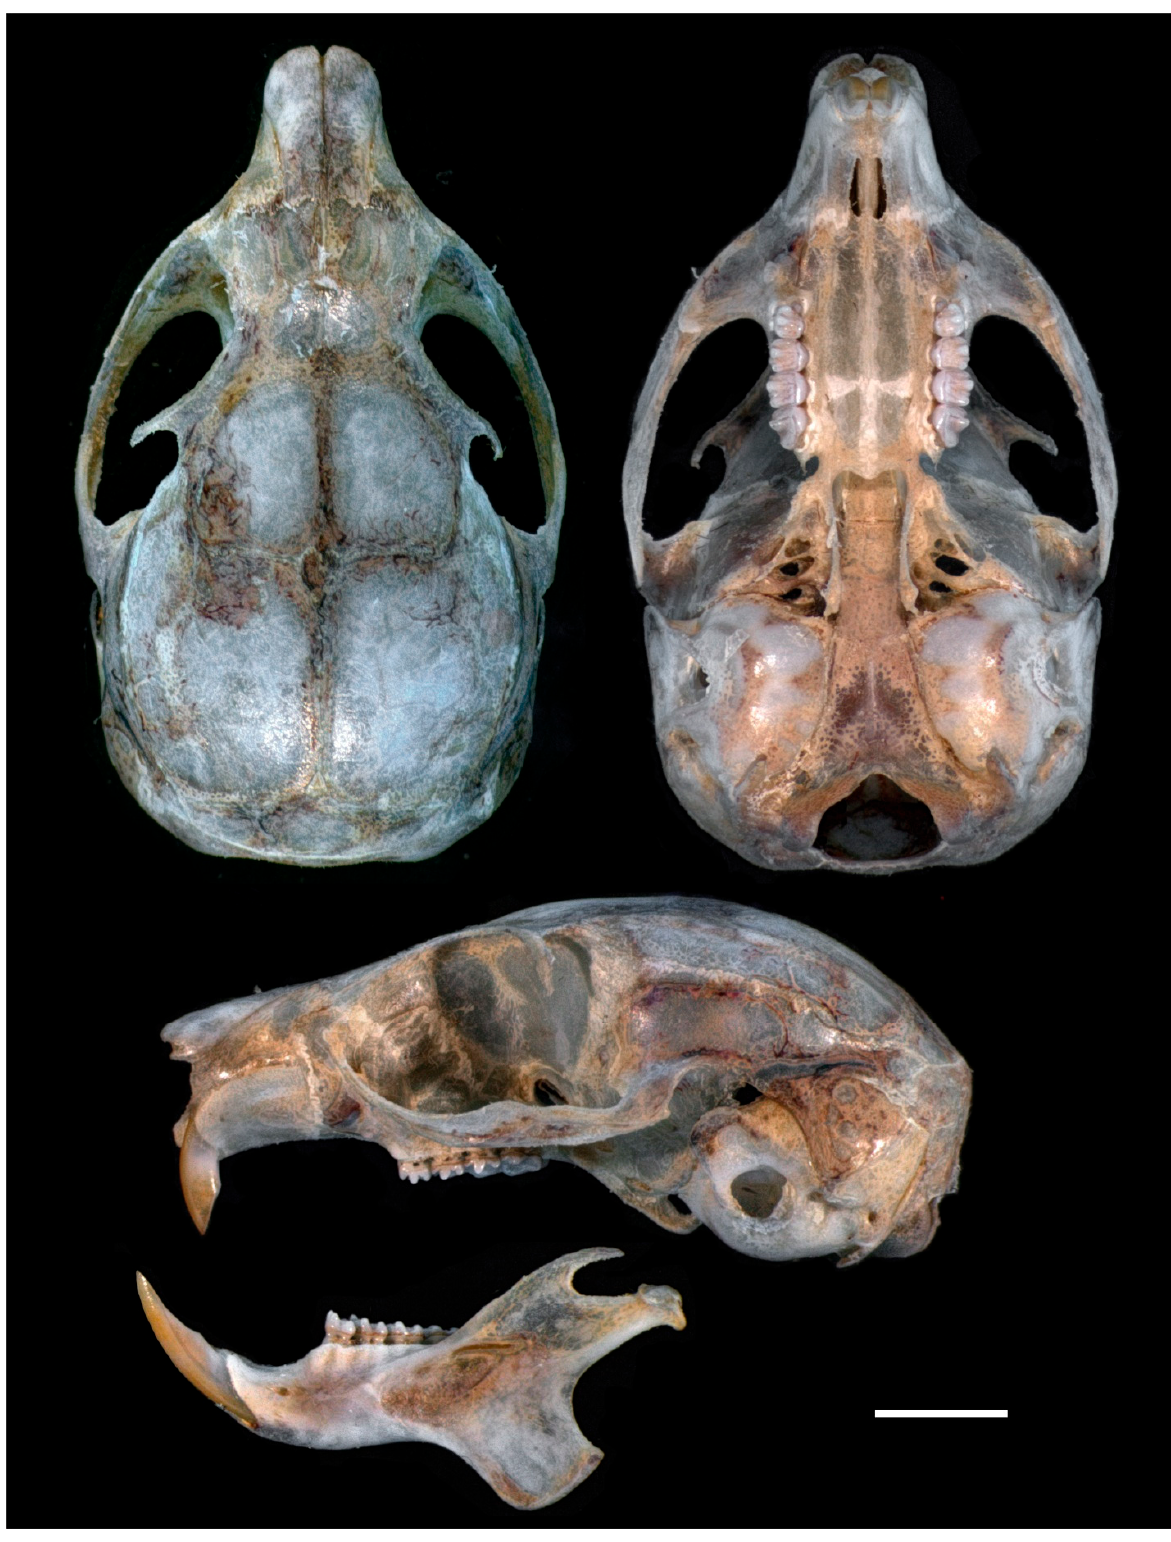
Figure 2. Upper, lower and lateral view of the skull and mandible of the specimen ZMMU S-207534 from Phu Yen Province. Scale bar 5 mm.